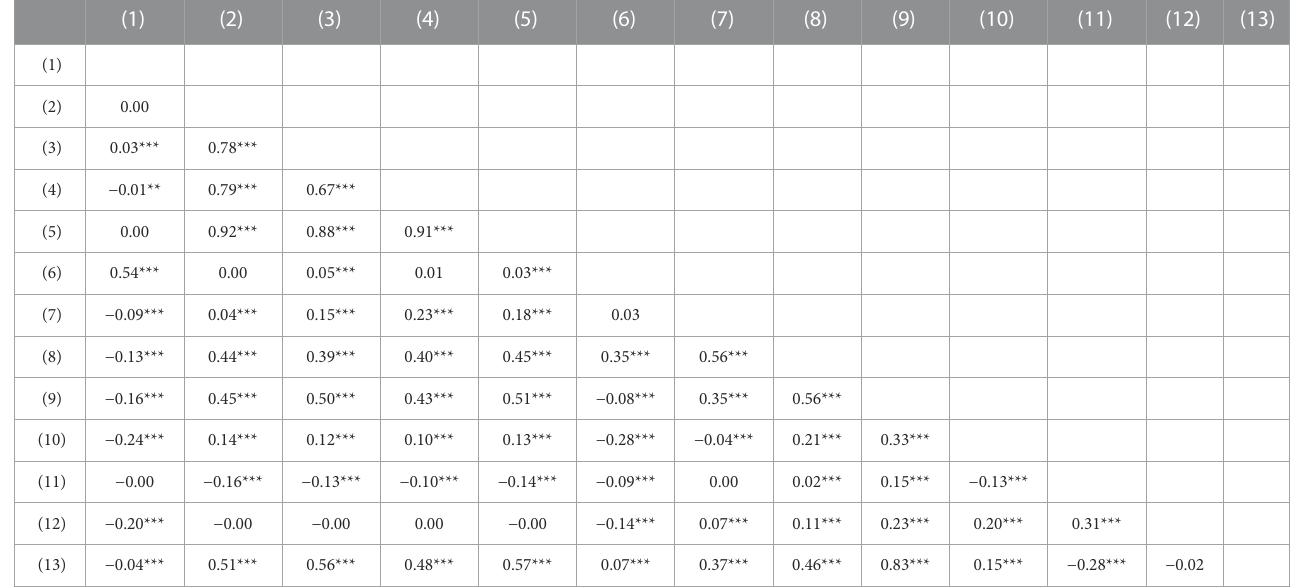
TABLE 3 Similarity matrix showing the correlation of each pair. (1) Tobin ’ s q, (2) Degree, (3) Betweenness, (4) Eigenvector, (5) CCI, (6) ROA, (7) lnAge, (8) BoardSize, (9) FirmSize,(10)Leverage,(11)Tangibility, (12)Growth, and(13)lnSale.ThistablepresentsthePearson correlation coef fi cientof thedependentvariableswithcentrality measures and control variables used in our analysis. Detailed variable descriptions are provided in Section 3.1. ** and ***, respectively, denote signi fi cance at 5% and